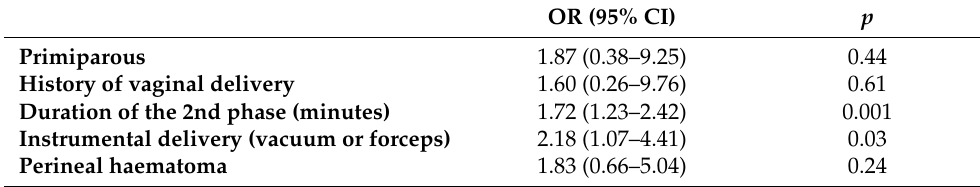
Table 5. Multivariate